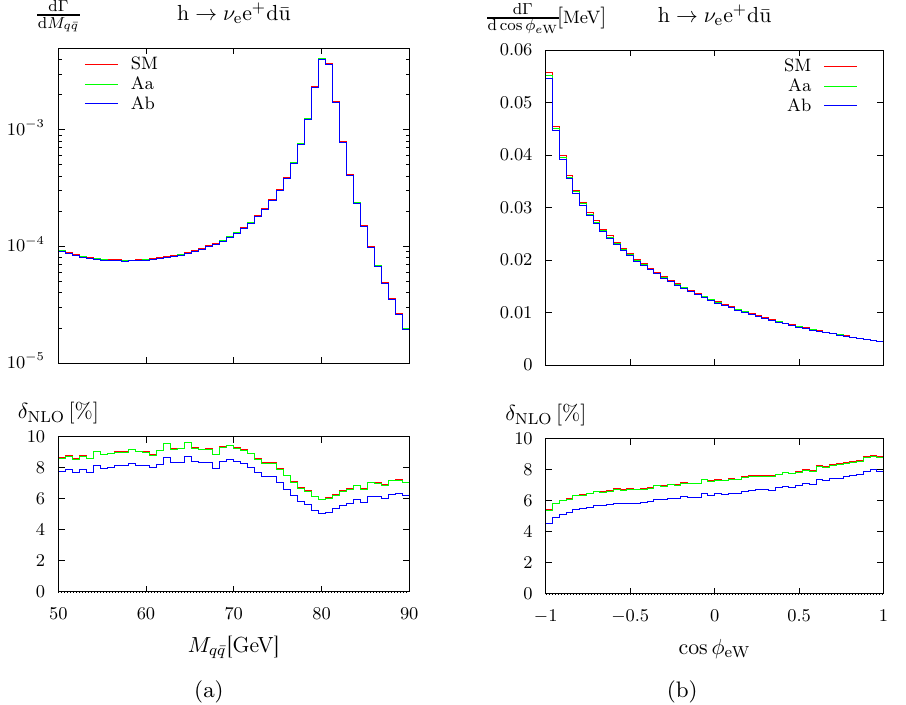
Figure 20 . As for (cid:12)gure 19, but for the charged-current semi-leptonic decay h de(cid:12)ne